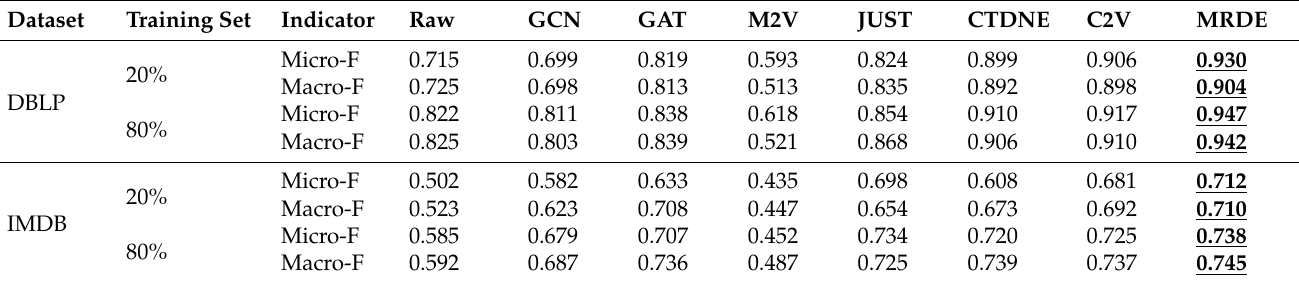
Table 2. Experimental values of the node classification